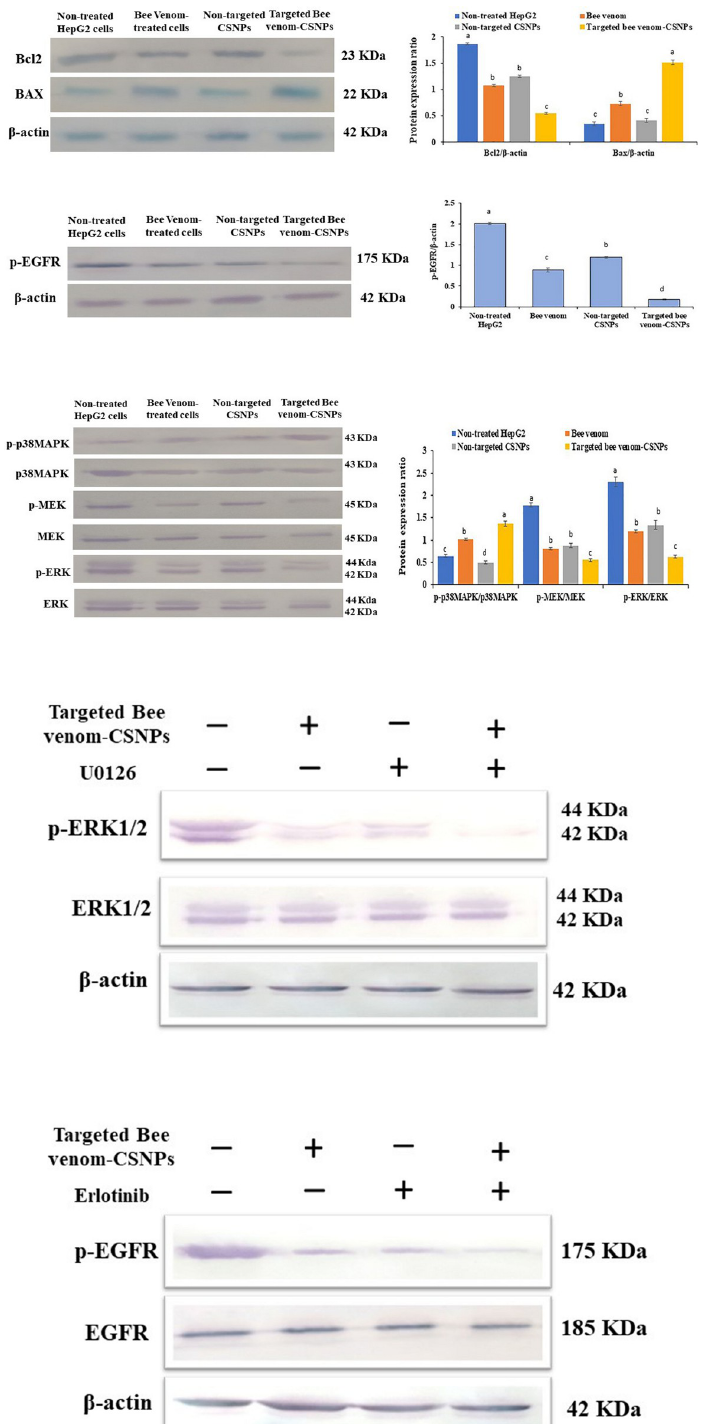
Fig 9. Activation of mitochondria-dependent apoptosis pathway and regulation of EGFR-mediated p38-MAPK/ MEK/ERK pathway by targeted bee venom-CSNPs. ( A ) Western blot analysis for the expression of Bcl-2 and Bax in HepG2 cells; ( B ) Western blot analysis for the expression of p-EGFR; ( C ) Western blot analysis for the expression of p38MAPK, p-p38MAPK, MEK, p-MEK, ERK, and p-ERK; ( D ) HepG2 cells were treated with targeted bee venom- CSNPs and/or U0126 for 24 h, and the protein levels of p-ERK1/2 and total ERK1/2 were detected; ( E ) HepG2 cells